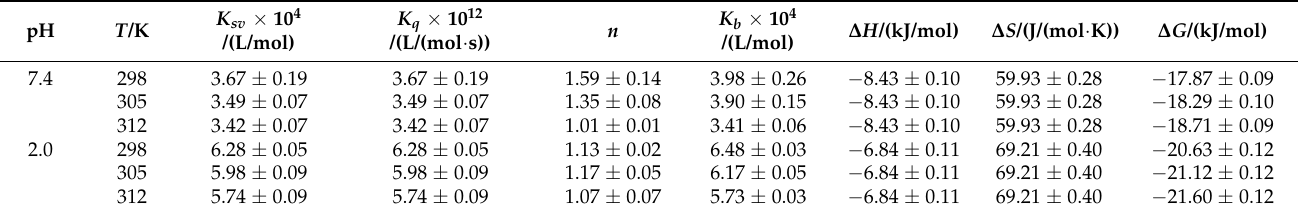
Table 1. Binding and thermodynamic parameters of casein-curcumin complex at different pH values and temperatures. pH T /K K sv × 10 4 /(L/mol)